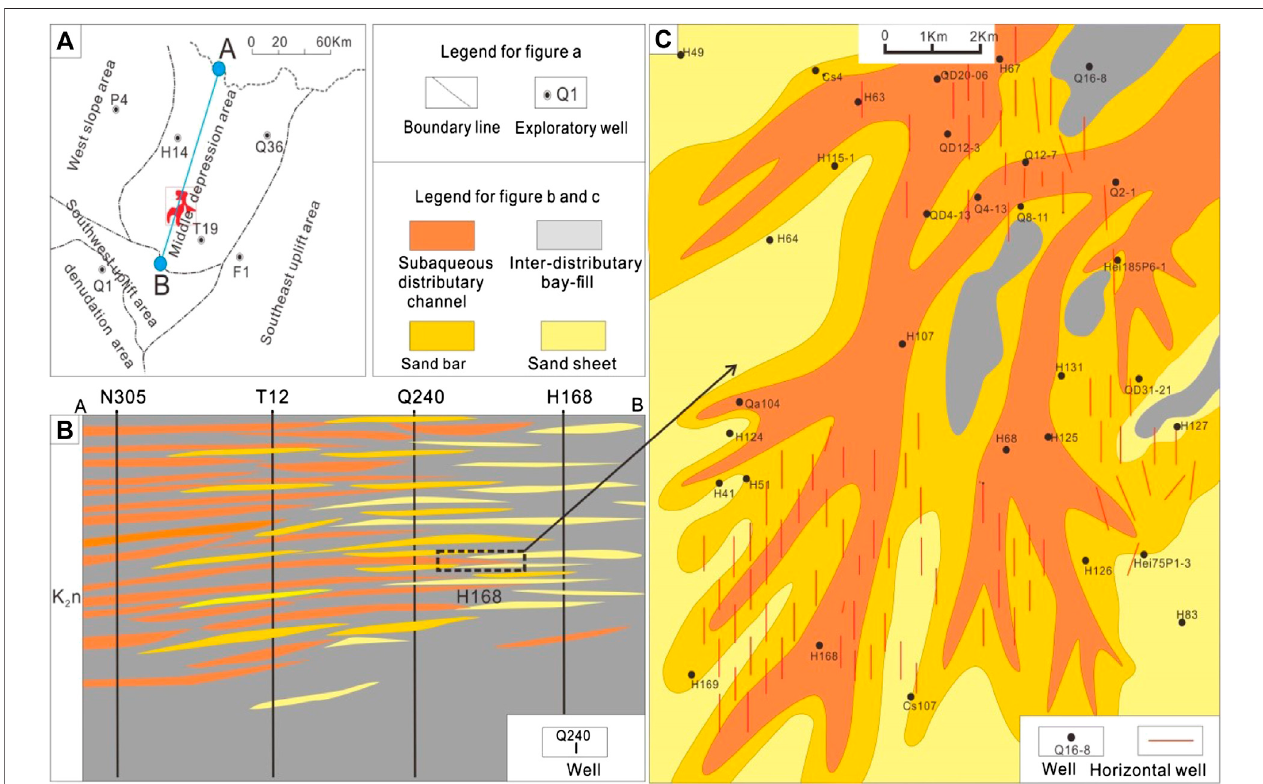
FIGURE 9 | Distribution map of sedimentary microfacies of the layer K2n46: (A) location of the southern Songlike Basin; (B) lithological pro fi le of connecting wells, planar graph of the sedimentary microfacies.